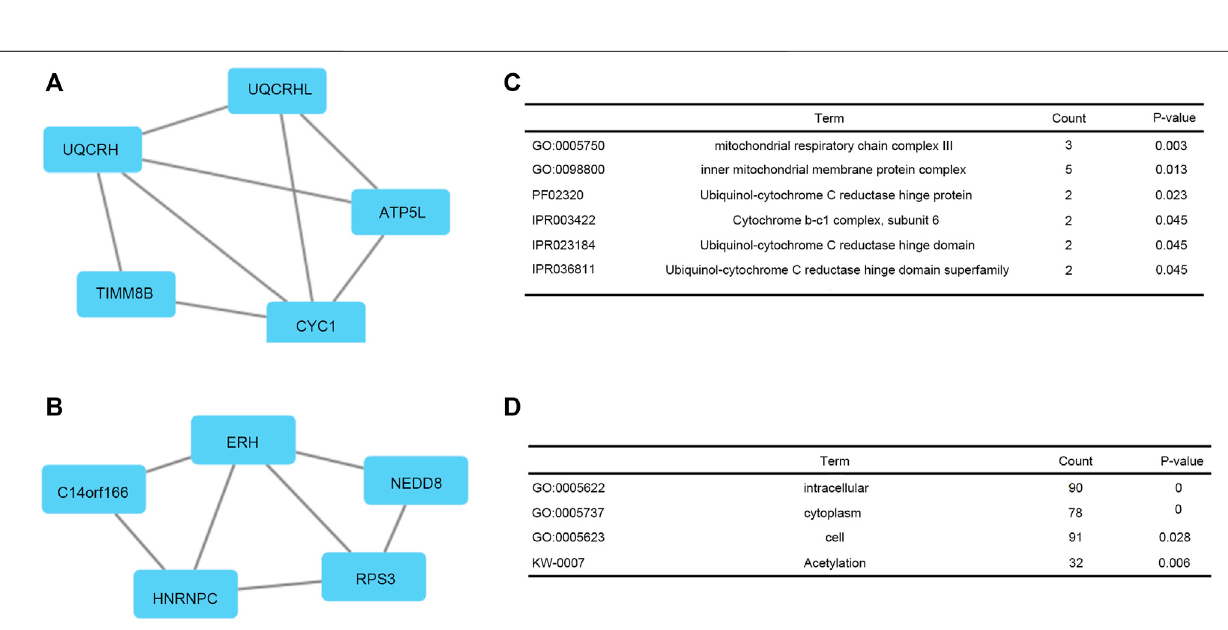
macrophage, and Treg cell marker genes in GEPIA ( Table 4 ). relevance to TAM, M1 macrophage, M2 macrophage, and Treg genes.